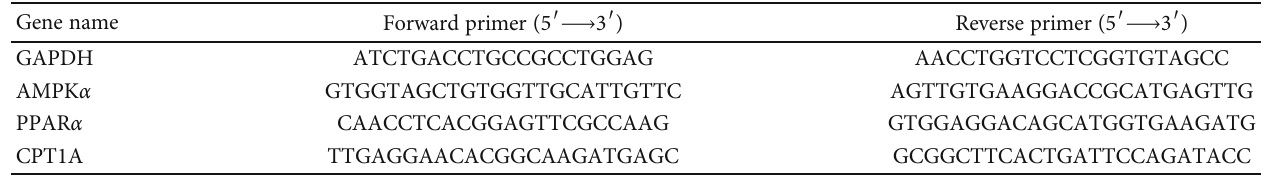
Table 1: Gene-speci fi c primers used in this study.